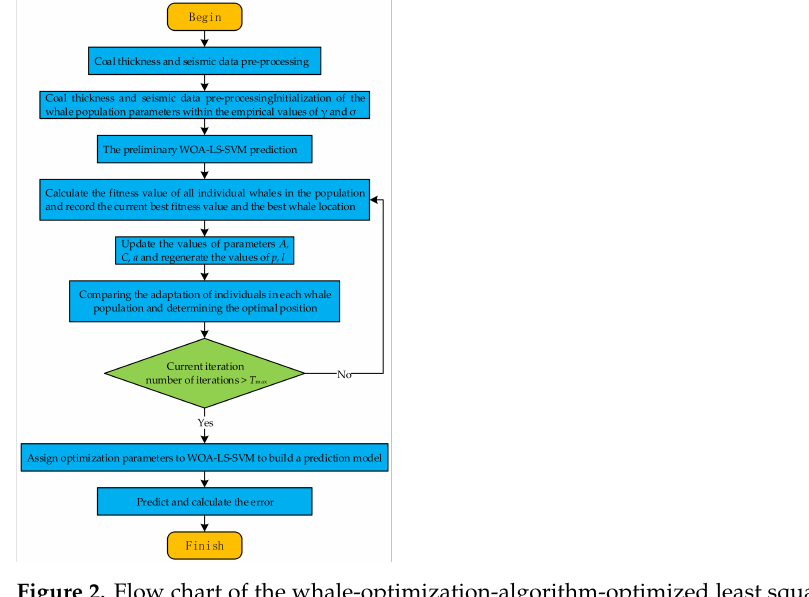
Figure 2. Flow chart of the whale-optimization-algorithm-optimized least squares support vector machine (WOA–LS-SVM) coal thickness prediction model